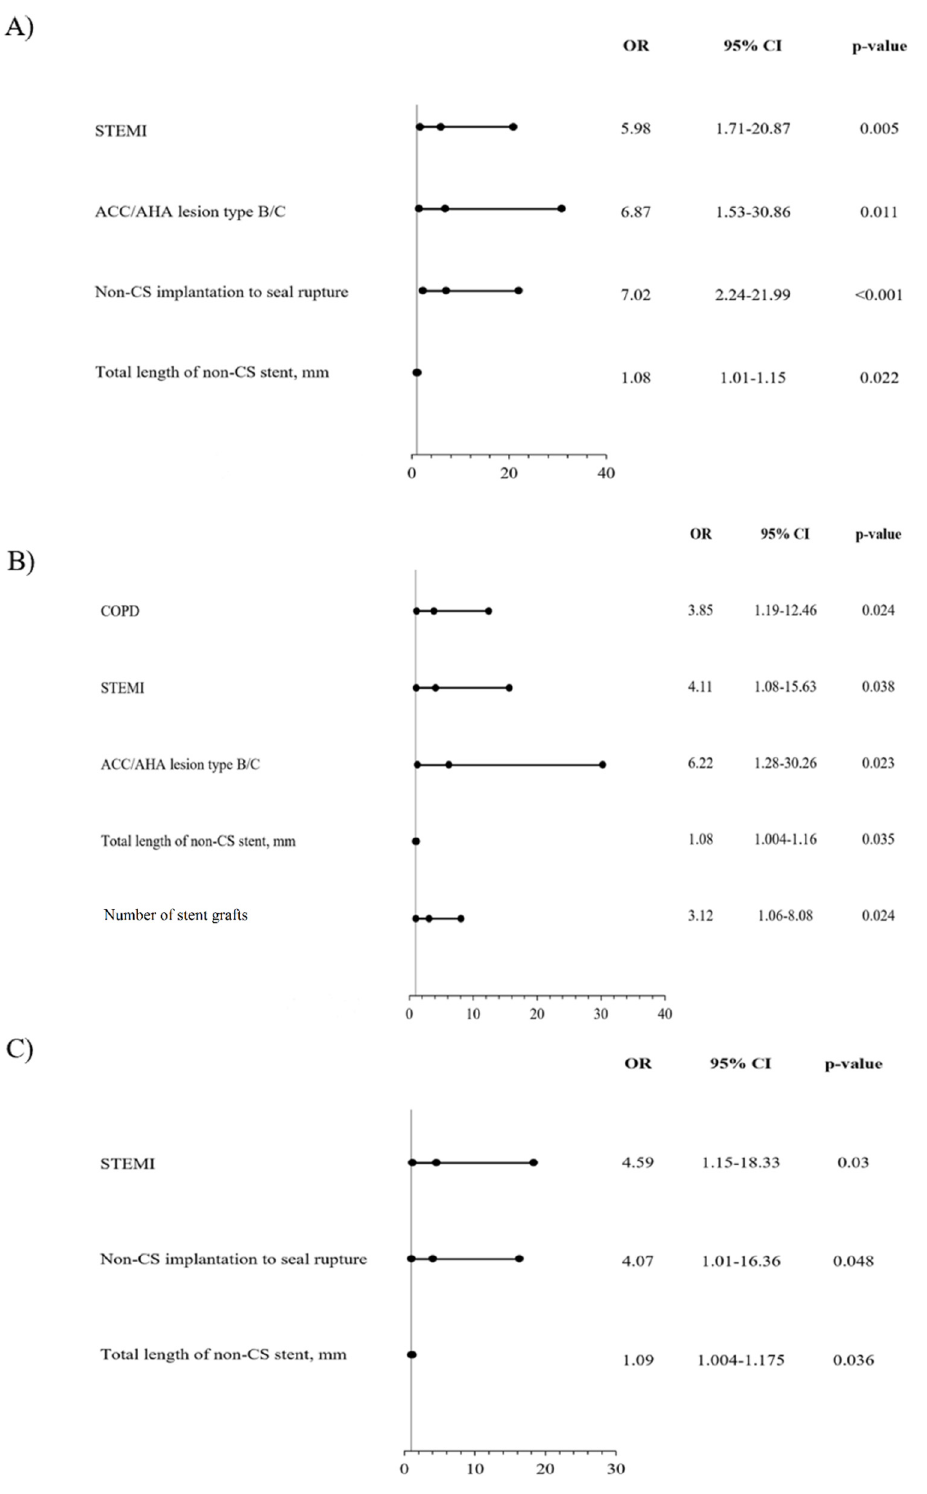
Figure 3. Predictors of selected clinical outcomes assessed by multivariable analysis-models adjusted for age, sex and BMI; ( A ) recurrent percutaneous coronary intervention (re-PCI); ACC/AHA, Amer- ican College of Cardiology/American Heart Association; CS, covered stent; STEMI, ST-segment elevation myocardial infarction. ( B ) Target vessel revascularisation (TVR); ACC/AHA, American College of Cardiology/American Heart Association; CS, covered stent; COPD, chronic obstructive pulmonary disease, ST- segment elevation myocardial infarction. ( C ) Target lesion revascularisation (TLR); CS, covered stent; STEMI, ST- segment elevation myocardial